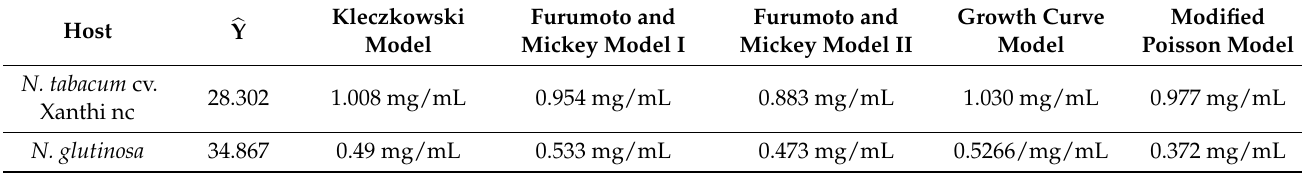
Table 4. Predicted concentration of a spike sample with 0.4 mg/mL ToBRFV based on different models.